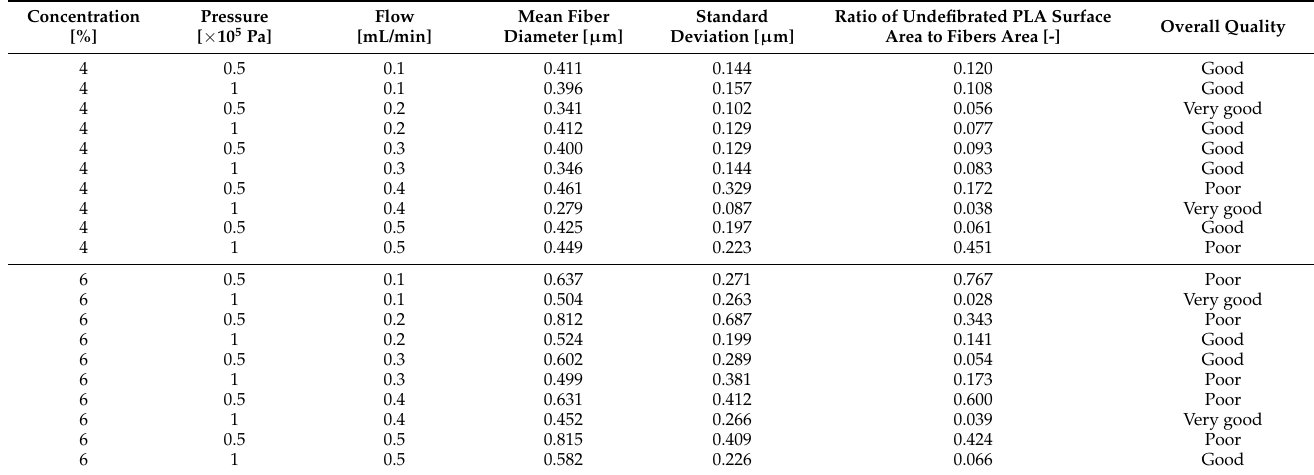
Table 1. Tested parameters of PLA